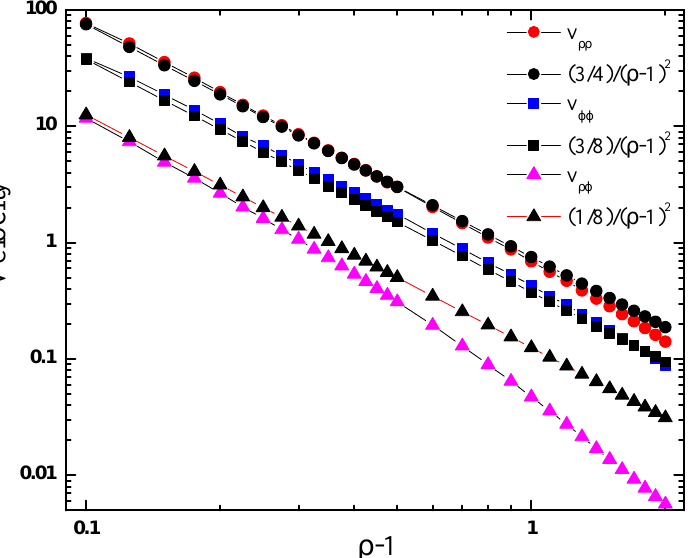
Figure A3. Particle drift velocity due to ICEO flow reflected on a cylinder versus the distance to the cylinder